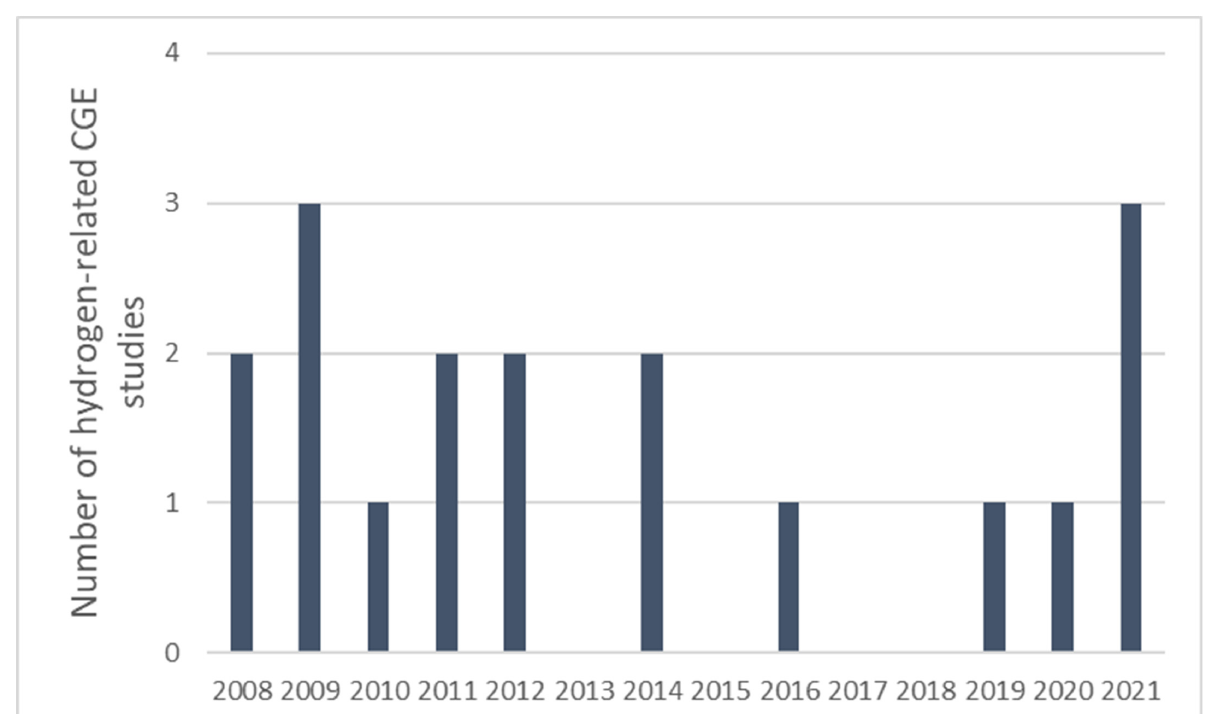
Figure 5. Number of computable general equilibrium models dealing with hydrogen, published per year.